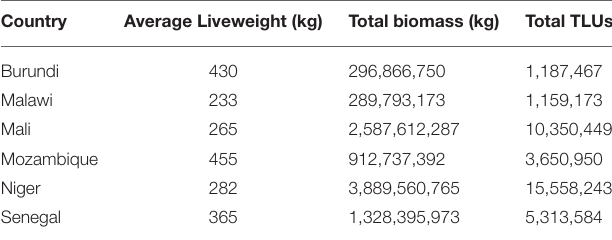
TABLE 3 | Biomass estimates derived through by compartmentalization of specific country breed and associated weight data into an assumed herd structure. Country